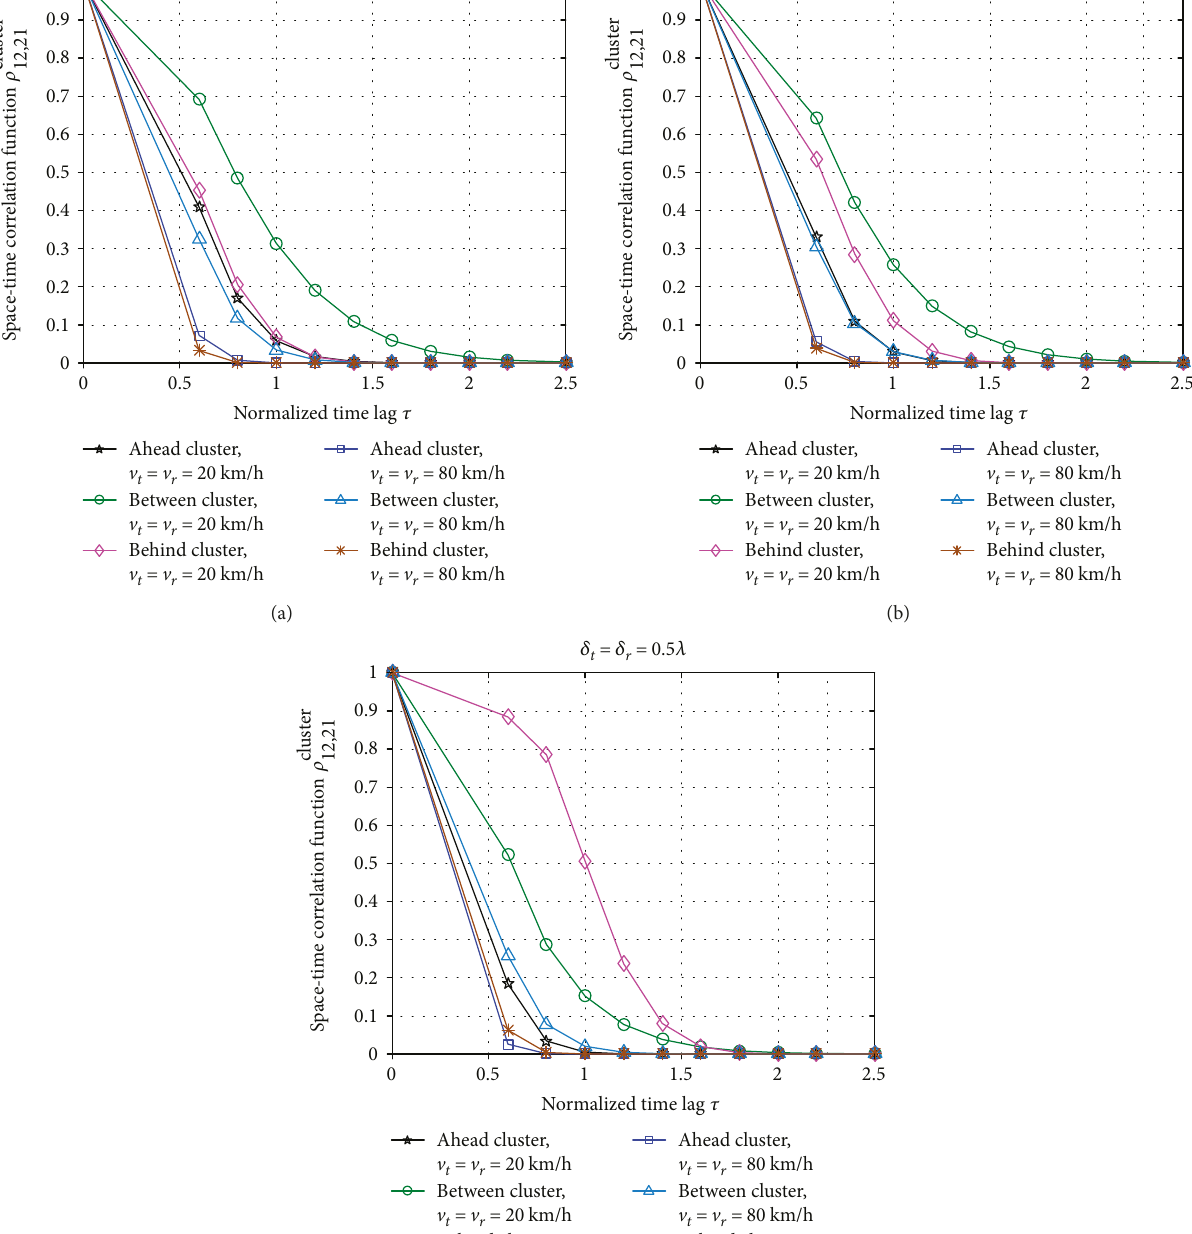
Figure 6: The absolute value of the 3D STCF ρ cluster